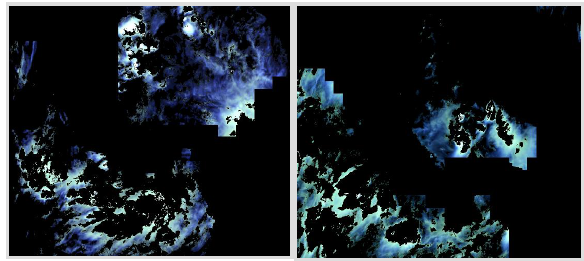
Fig. 4. Same as Fig. 3 except a cloud mask was applied to show only cirrus clouds (white-to-bluish